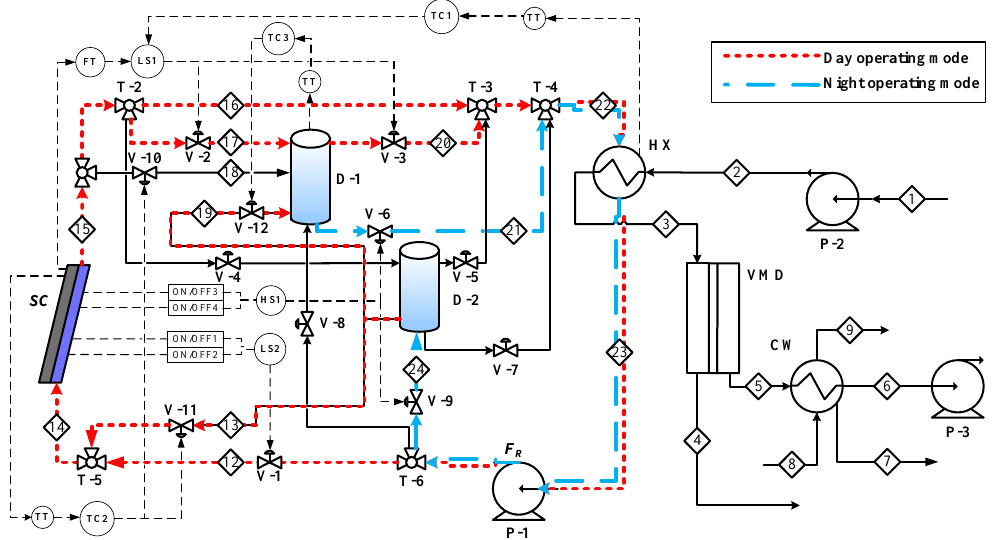
Figure 5. The control structure of the solar-driven VMD system for desalination.